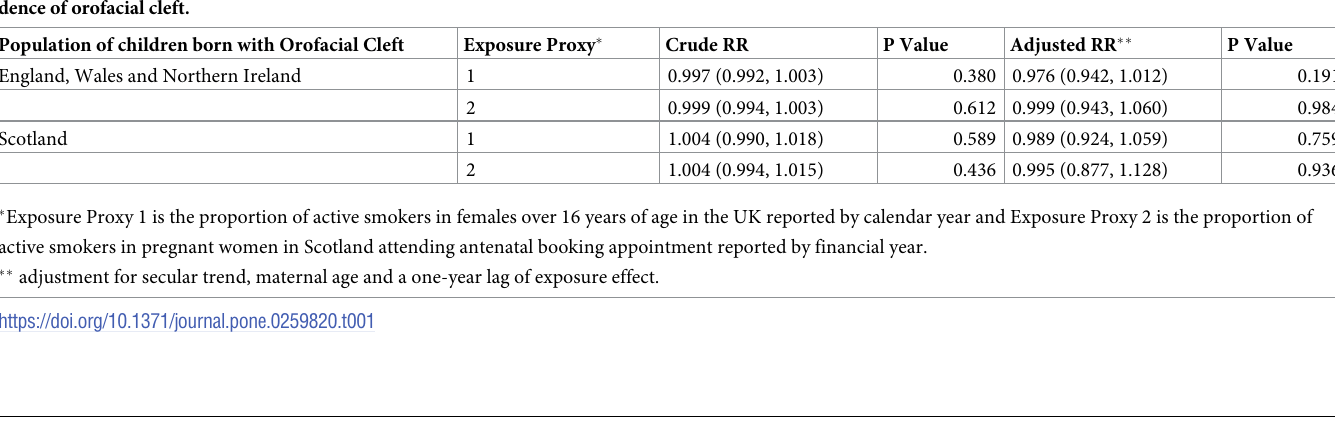
Fig 4. Sensitivity analyses to model the implementation of the smoking ban in 11 additional years in EWNI showed no evidence to suggest a decreasing level change in OFC incidence in any other year but there was a step level increase in 2003 (see S4 Appendix). Our interrupted time-series analysis strategy in EWNI scored a low risk of bias on six of the seven EPOC crite- ria (see Table 2). The risk to external validity from additional time varying factors occurring